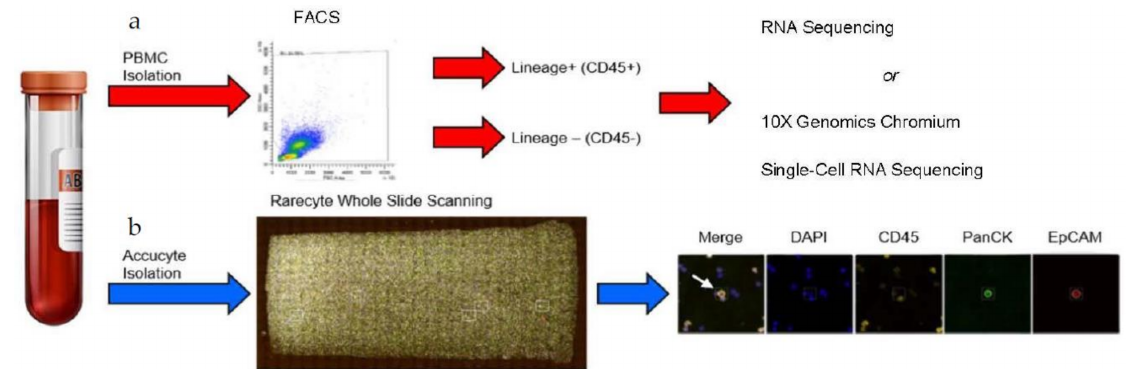
Figure 1. Flowchart depicting the strategy for selection and interrogation of Lin − /Lin+ cell populations from mBC patients. Patient blood samples were collected into sodium-EDTA tubes, and each sample was sub-divided. ( a ) One portion of the blood sample was processed for isolating Lin − /Lin+ cell populations via FACs, followed by RNA Sequencing or scRNA-Sequencing. See “Section 2” for details. ( b ) A 7.5 mL portion of the blood sample was transferred to an AccuCyte collection tube for RareCyte